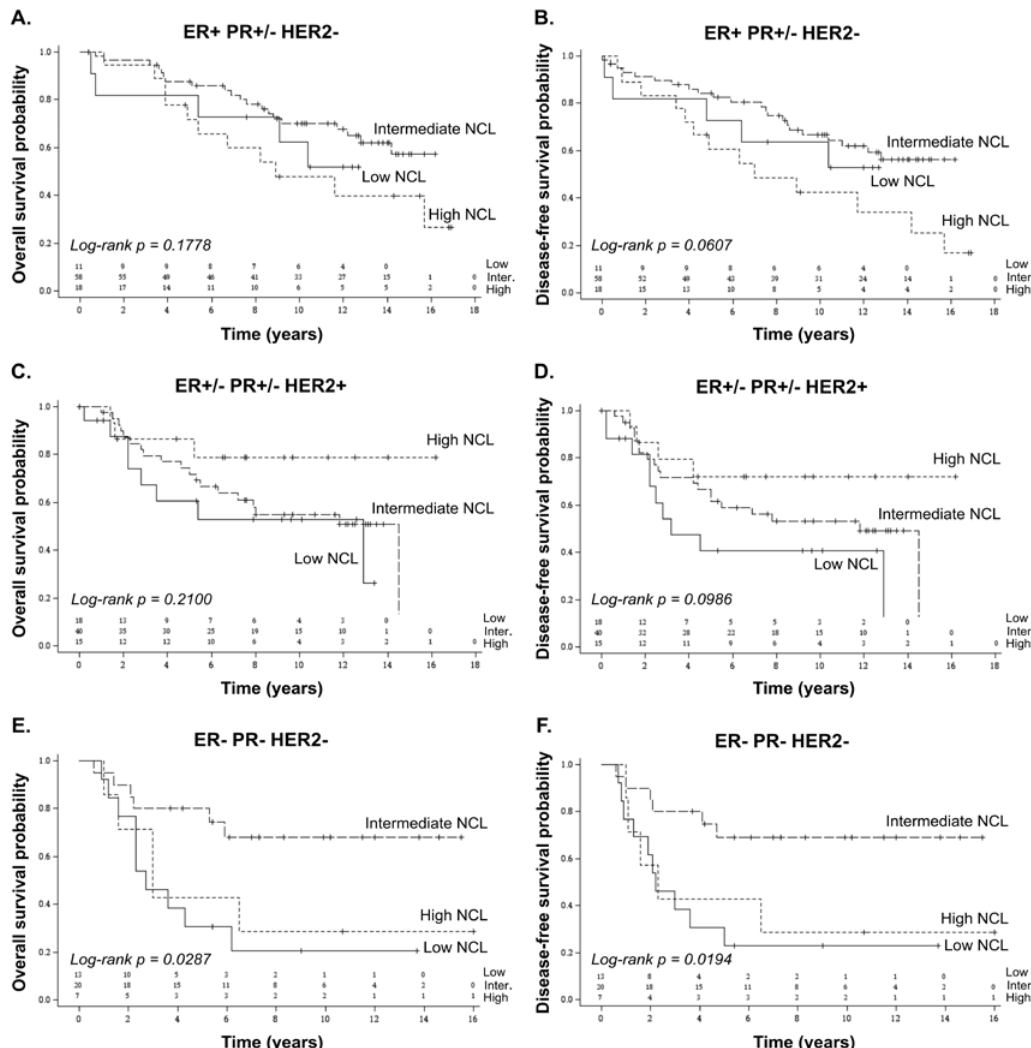
Figure 2. Association of NCL expression levels with poor prognosis in breast cancer subtypes using Dundee series. Overall ( A , C , E ) and disease-free survivals ( B , D , F ) in relation to NCL expression levels were analysed in tumours exhibiting different hormonal status: ER+ PR+/ − HER2 − (equivalent to the luminal subtype, A , B ); ER+/ − PR+/ − HER2+ (equivalent to the HER2 subtype, C , D ); and ER − PR − HER2 − (equivalent to the triple-negative subtype, E , F ). While NCL expression levels were not associated with survivals in patients carrying ER+ PR+/ − HER2 − and ER+/ − PR+/ − HER2+ tumours, associations were observed between NCL expression levels and both overall and disease-free survivals in patients bearing ER − PR − HER2 − tumours. The association between NCL expression levels and survival was analysed using Kaplan–Meier representation. Number of subjects at risk is indicated on the graph for the three NCL groups (low; intermediate; high). Log-rank p -value ≤ 0.05 was used to determine significant association.